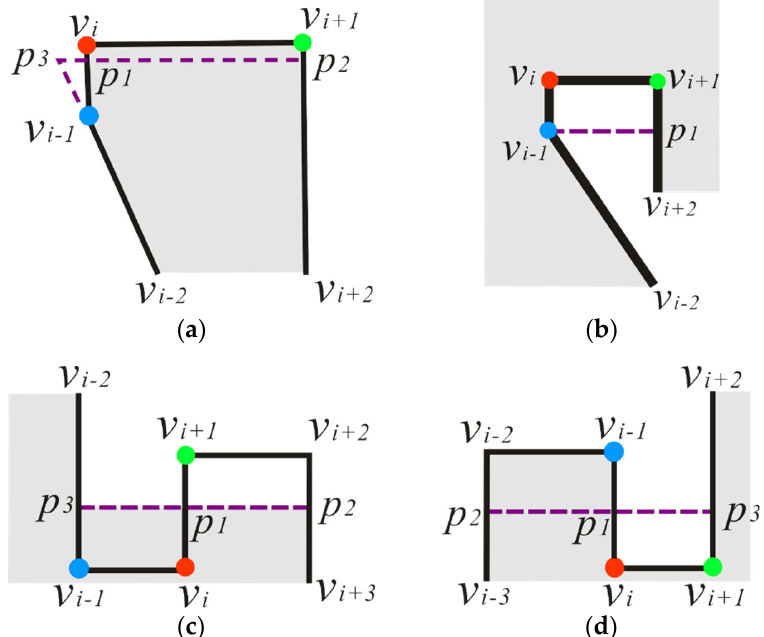
Figure 5. The simplification subtypes 1–4 and their operations. ( a ) Subtype 1, ( b ) subtype 2, ( c ) sub ‐ type 3, ( d ) subtype 4.